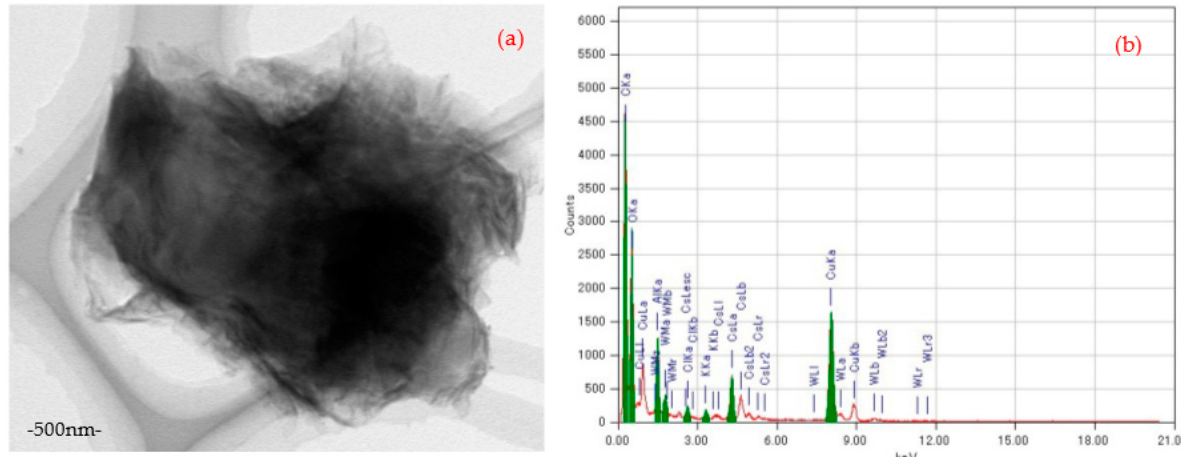
Figure 7. TEM image of [GO ₇₀ POM] 18 /Cs: ( a ) Aggregation after Cs adsorption, ( b ) Elemental analysis of Figure 7a. By FTIR spectra, specific changes are marked at 1150–1350 cm − 1 after Cs adsorption